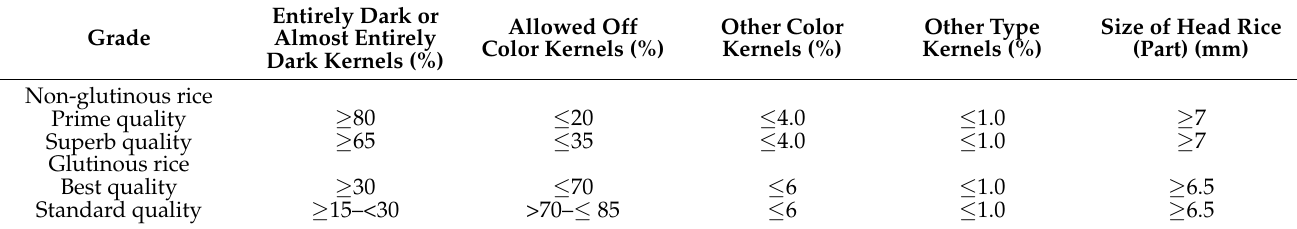
Table 1. Thailand’s export quality standard specifications for pigmented rice.